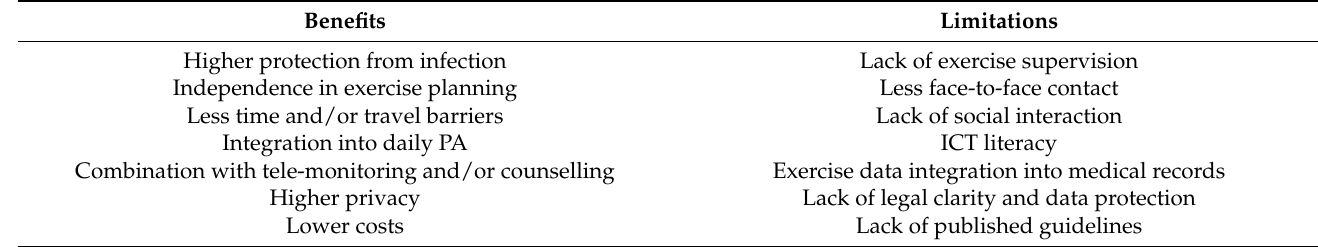
Table 3. Benefits and potential limitations of HB cancer exercise